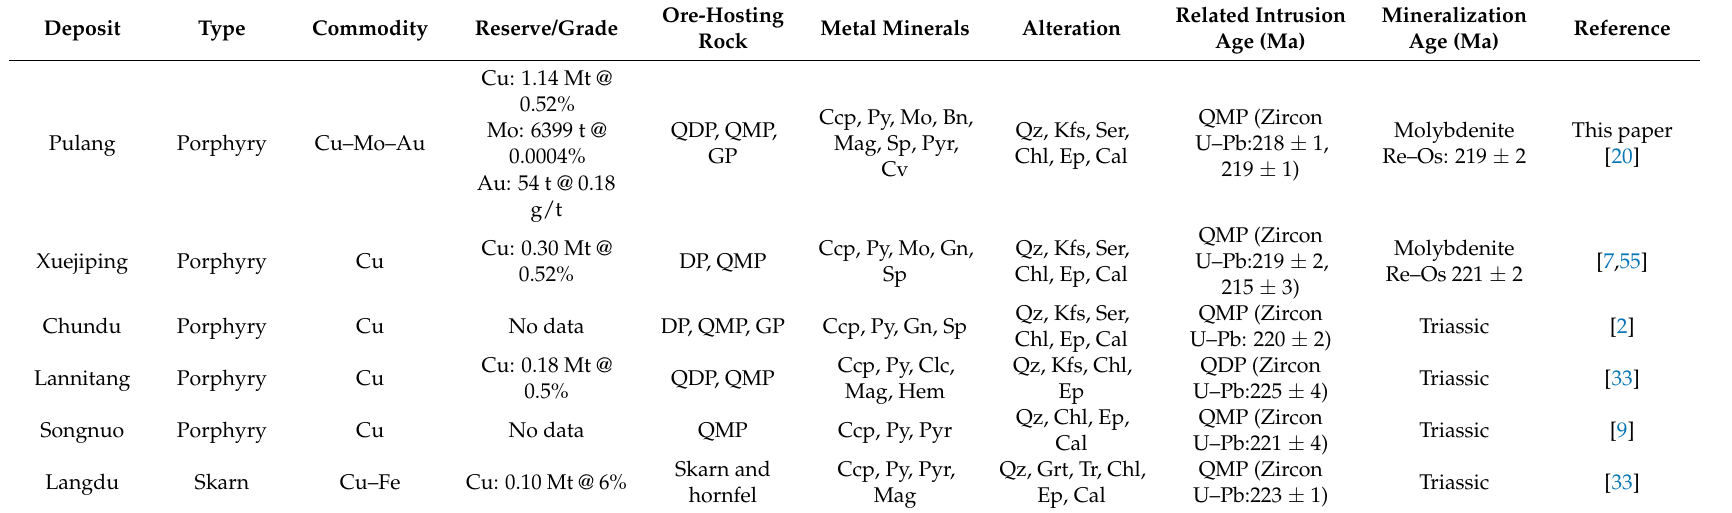
Table 3. Geological characteristics of the major Late Triassic Cu deposits in the southern Yidun